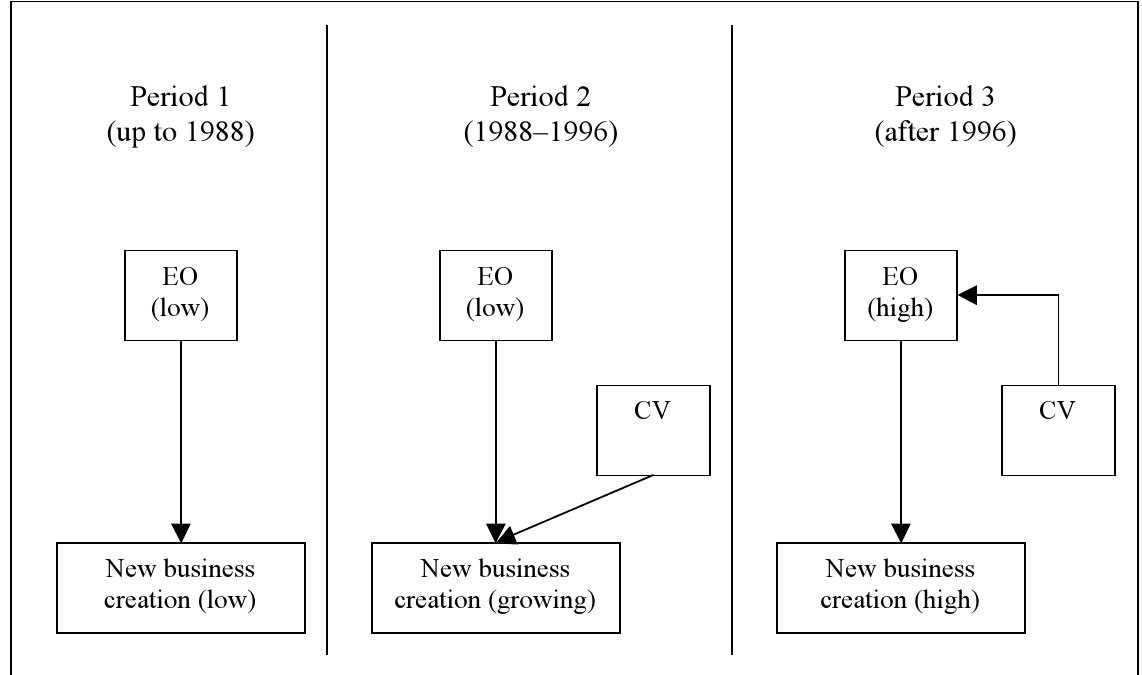
Figure 1. Entrepreneurial Orientation, Corporate Venturing,